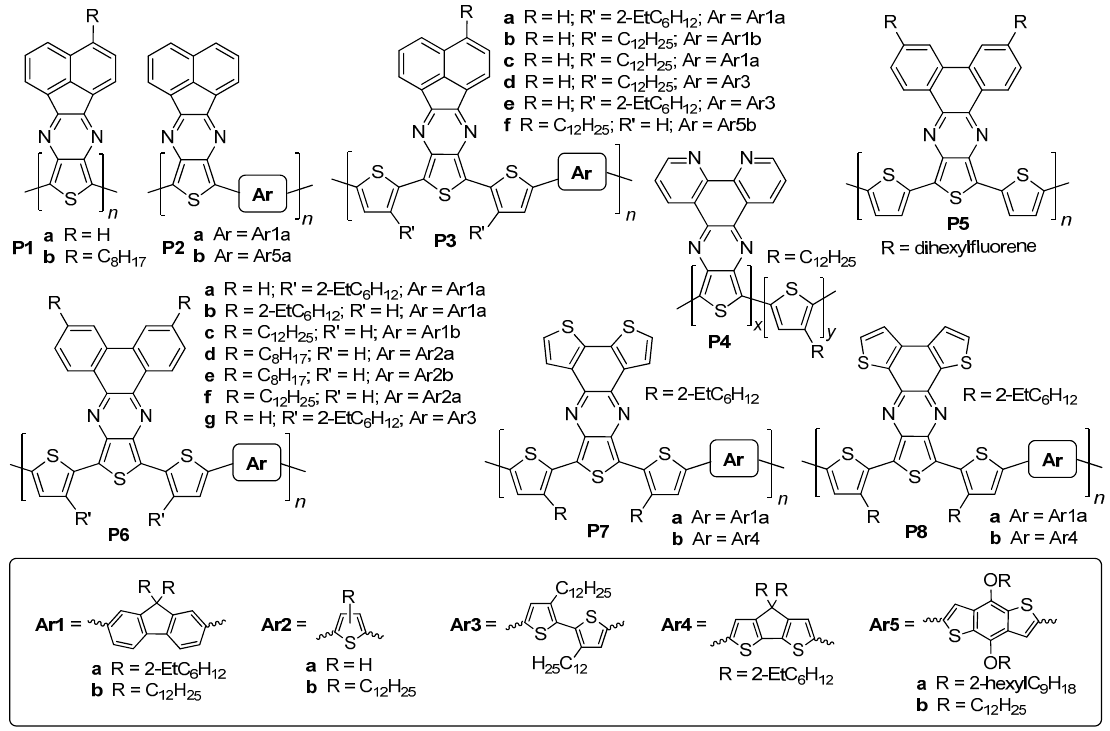
Figure 3. Polymeric materials incorporating extended fused-ring thieno[3,4- b ]pyrazine analogues.